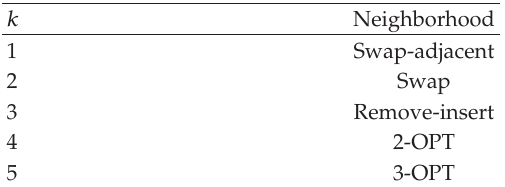
Table 4: The neighborhoods and their applied order in the VNS improvement